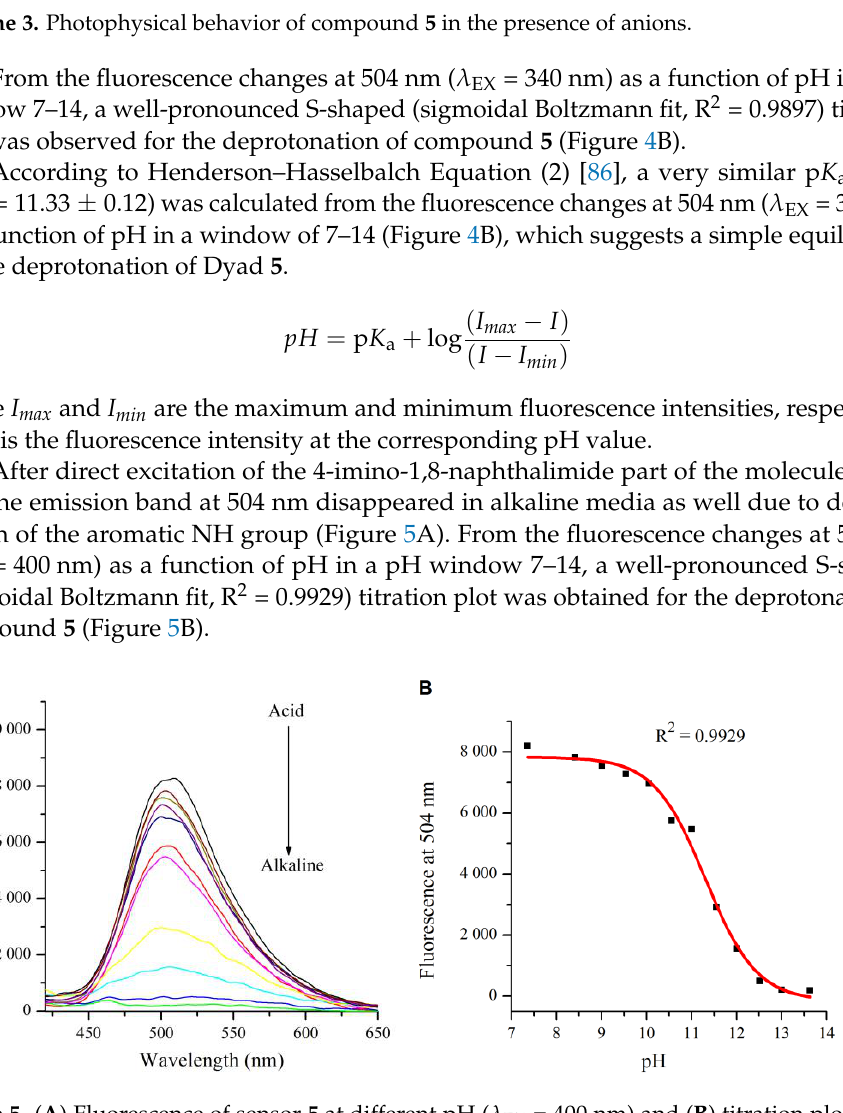
Figure 5. ( A ) Fluorescence of sensor 5 at different pH ( λ EX = 400 nm) and ( B ) titration plot of 5 at λ F = 504 nm in a pH range of 7 – 14 ( λ EX = 400